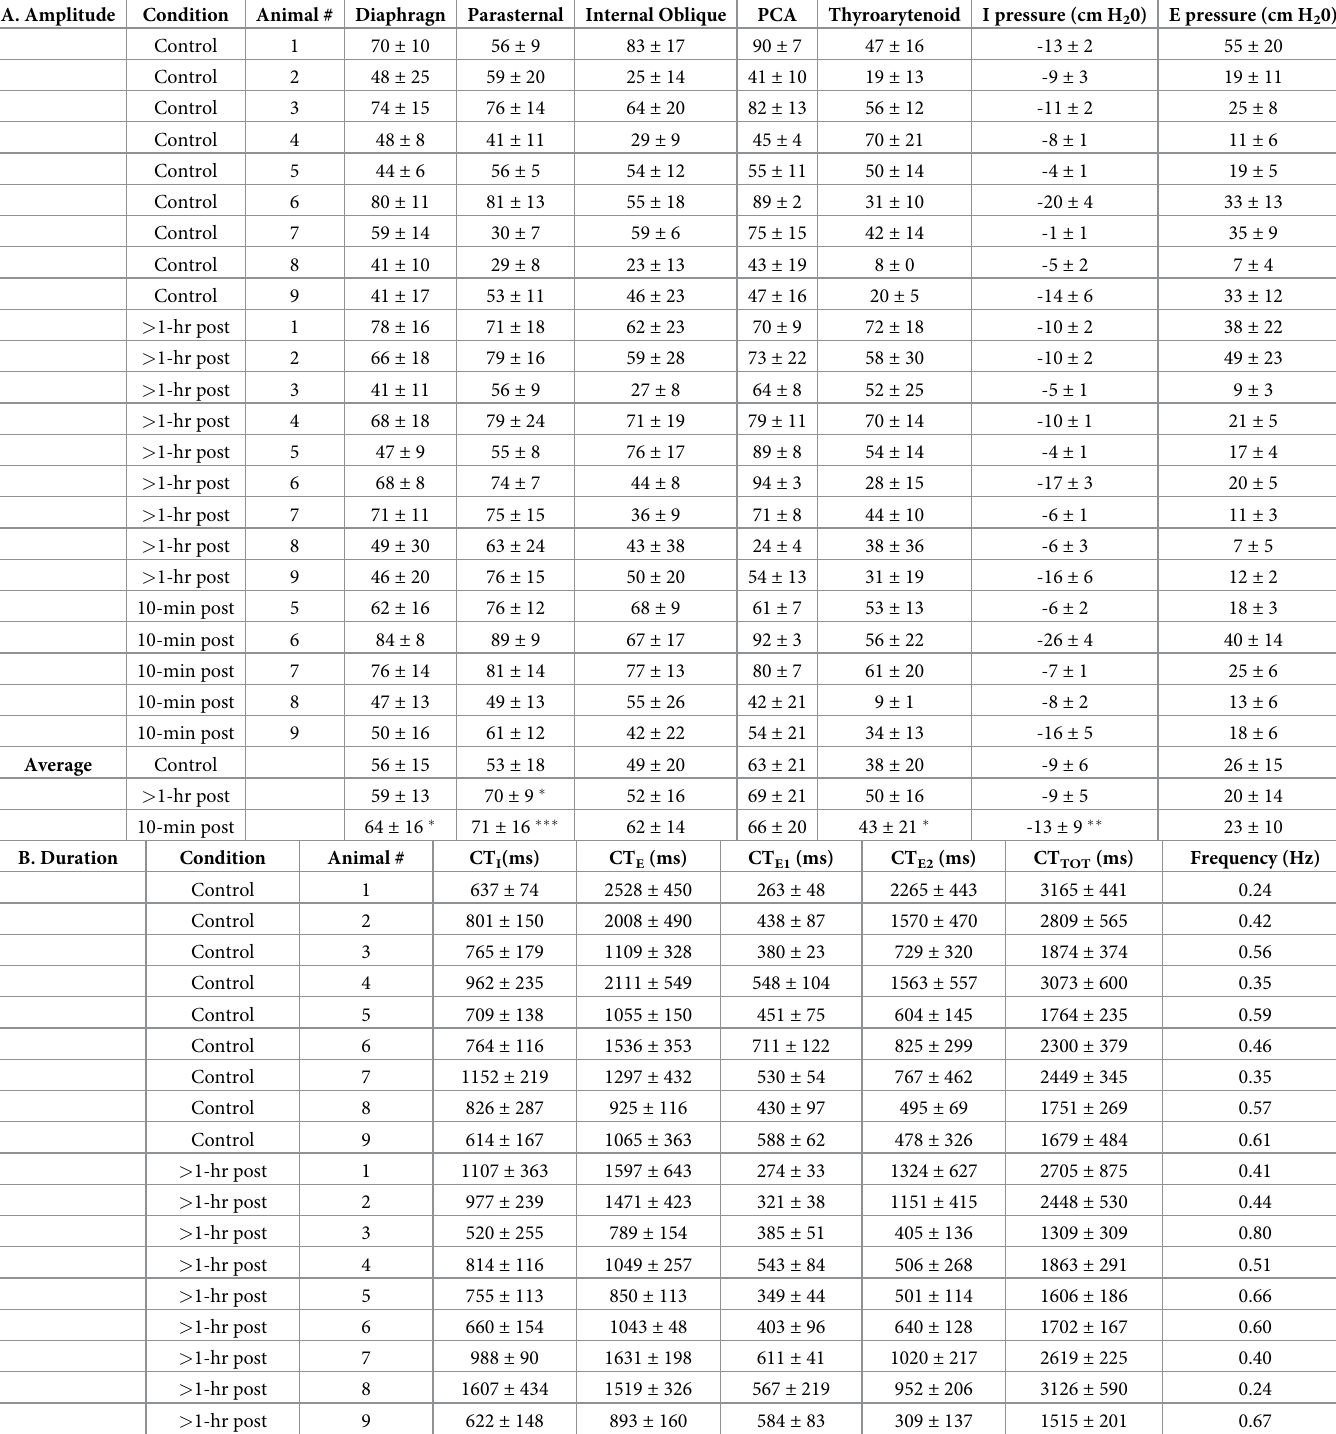
Table 1. Raw means and standard deviations for cough. (A.) EMG amplitudes (% of maximum), esophageal pressures (cm H 2 0), (B.) phase durations (ms) and cough frequency (Hz) for each animal and across animals for each condition. A.